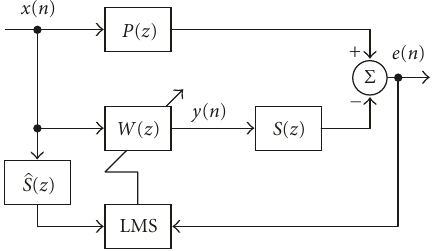
Figure 5: Block diagram of the FXLMS algorithm.